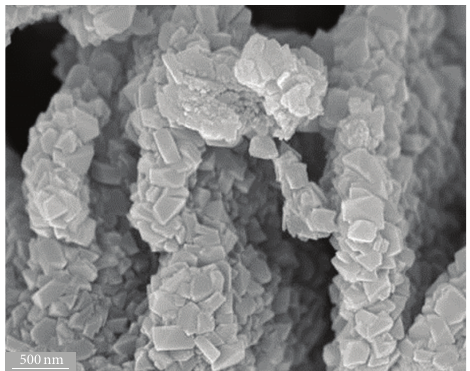
Figure 12: Scanning electron microscope pictures of BASF’s Endurance nanocatalysts (obtained by and used with permission from